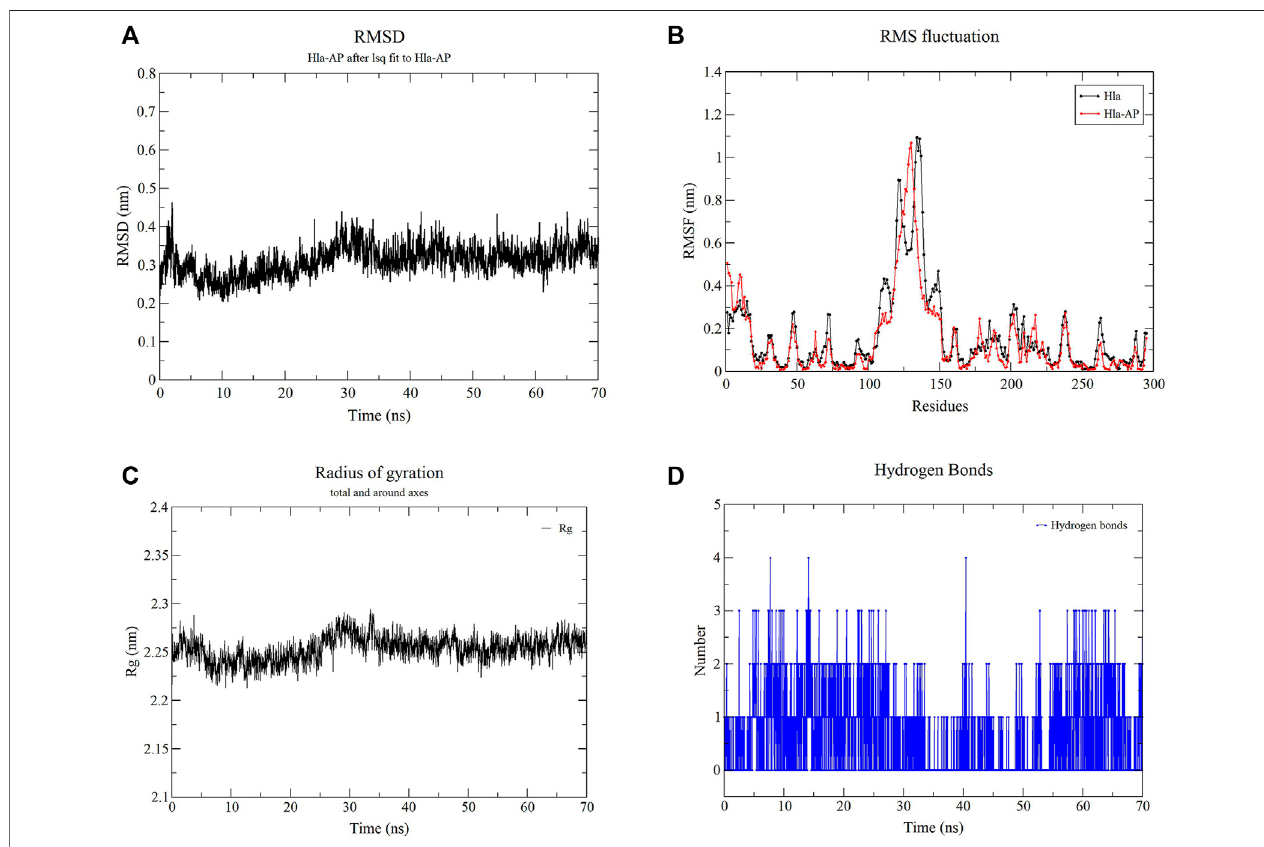
FIGURE9| MoleculardynamicssimulationofthecomplexofHla – AP.Note: (A) presentstheRMSDofthecomplexofHla-AP; (B) presentstheRMSFofthefreeHla protein and the complex of Hla-AP; (C) presents the Rg of the complex of Hla-AP; (D) presents the number of hydrogen bonds formed between Hla and AP.